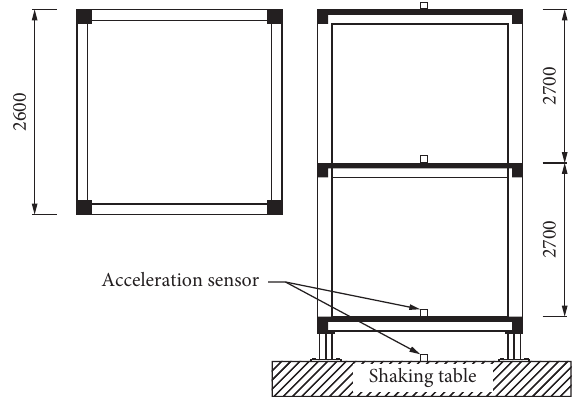
Figure 3: Plan view of upper frame